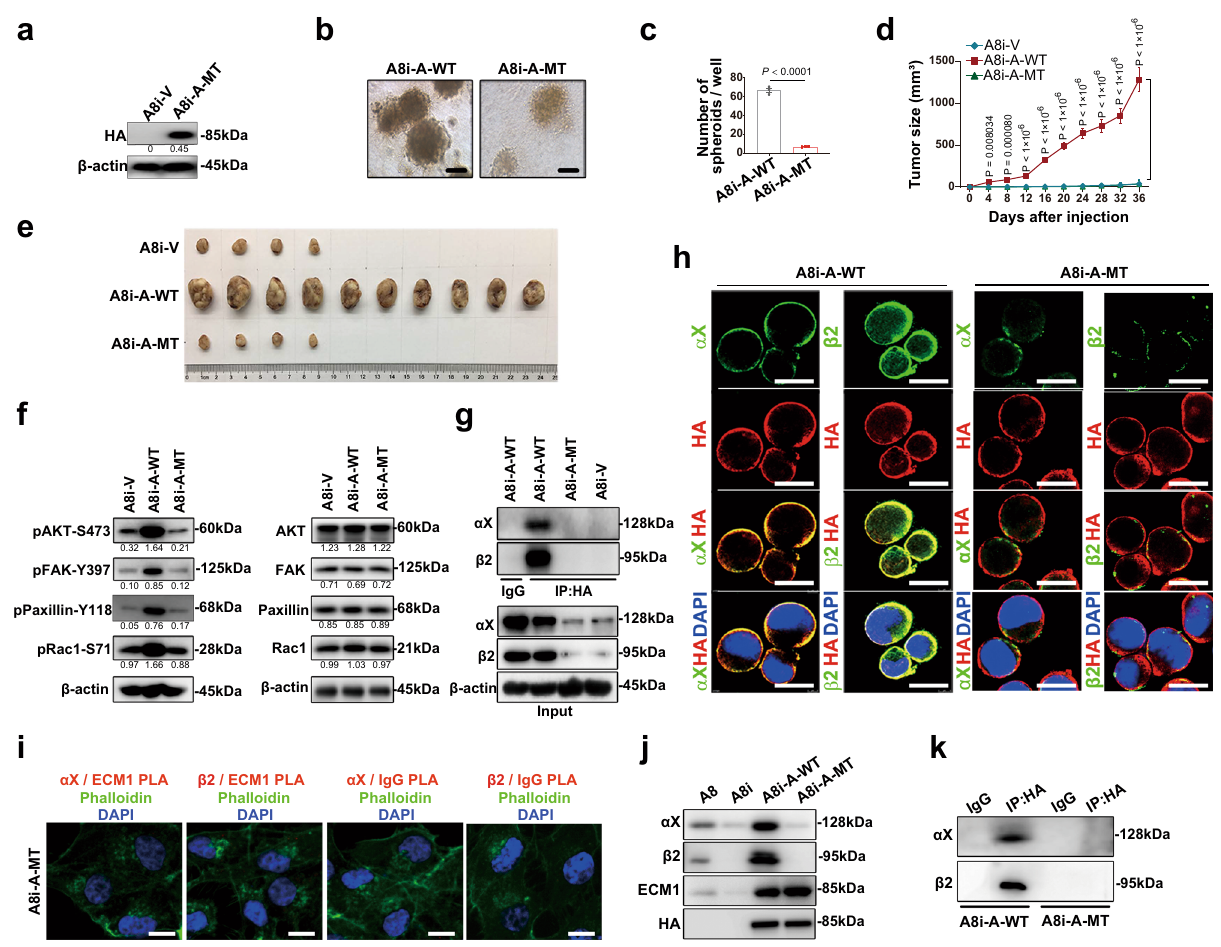
Fig. 3 The ECM1a GPR motif determines signaling and tumorigenesis. a Detection of HA-tagged ECM1a-MT expression in an established cell line by WB analysis. 3D cell growth ( b , bars = 400 µ m) and quanti fi cation ( c , data are presented as mean ±SD, n = 3 biologically independent repeats, two-tailed t -test) induced by ECM1a-MT or ECM1a-WT. Xenograft tumor growth ( d , data are presented as mean ±SD, n = 10v10 mice, two-tailed t -test) and tissues ( e ) in ten mice and cellular signaling molecules ( f , the actin loading control in f left panel was also used for the same samples in Fig. 4g because these tests were parallelly performed) were inhibited by ECM1a-MT. g Loss of direct binding of integrin α X or β 2 to ECM1a-MT, in contrast with the binding to ECM1a-WT, as tested by co-IP. Cellular colocalization of integrin α X or β 2 with ECM1a-WT or ECM1a-MT as detected by IF ( h , bars = 10 µ m) and PLA ( i , bars = 10 µ m). Detection of integrins α X and β 2 and of WT and MT ECM1 by WB analysis of cell membrane extracts ( j ) and detection of integrins α X and β 2 ( k ) by co-IP/WB analysis after cell surface labeling with biotinylation